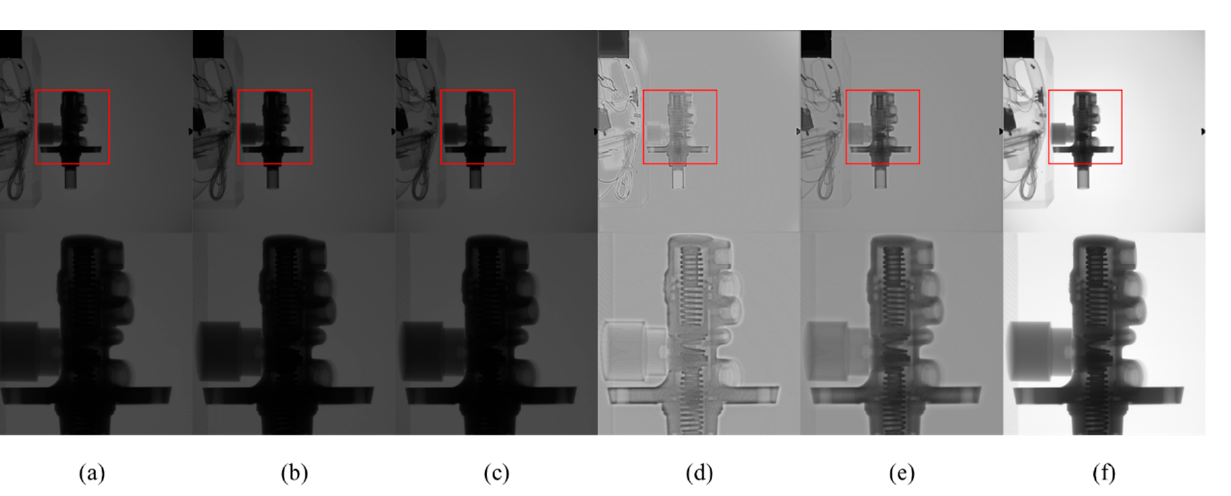
Table 2. Evaluation indicators of different methods.